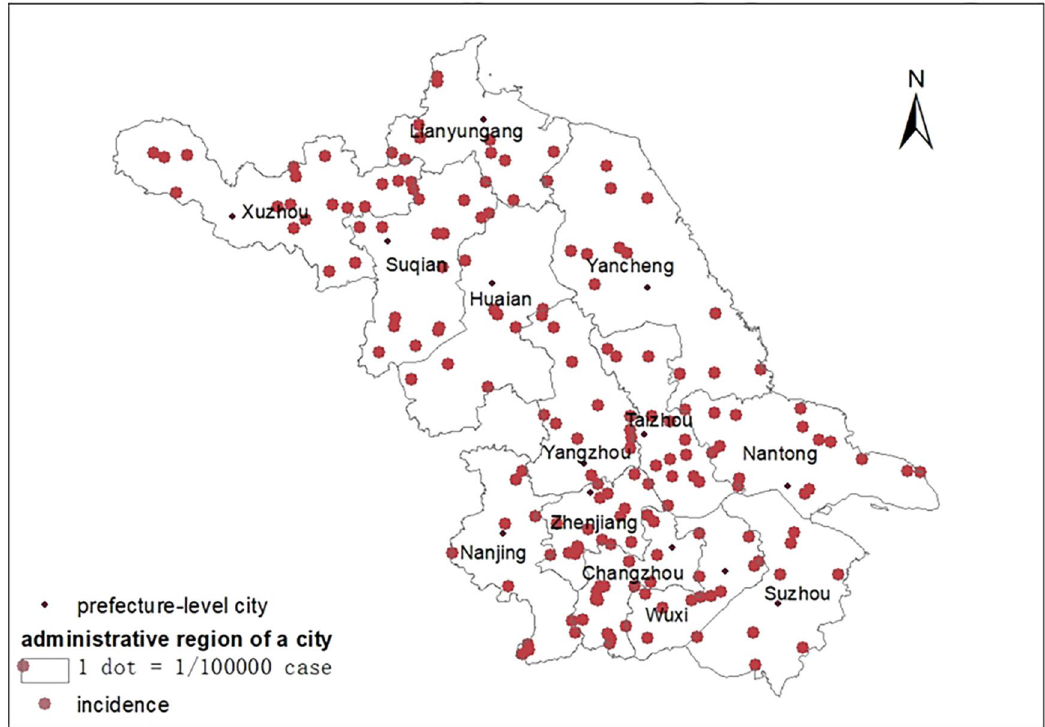
Figure 2. Distribution of the average aggregate annual incidence of Type A and B intestinal infectious diseases in Jiangsu Province during 2011–2019 (Map was created using ArcGIS version 10.6; https:// deskt op. arcgis. com/ en/).